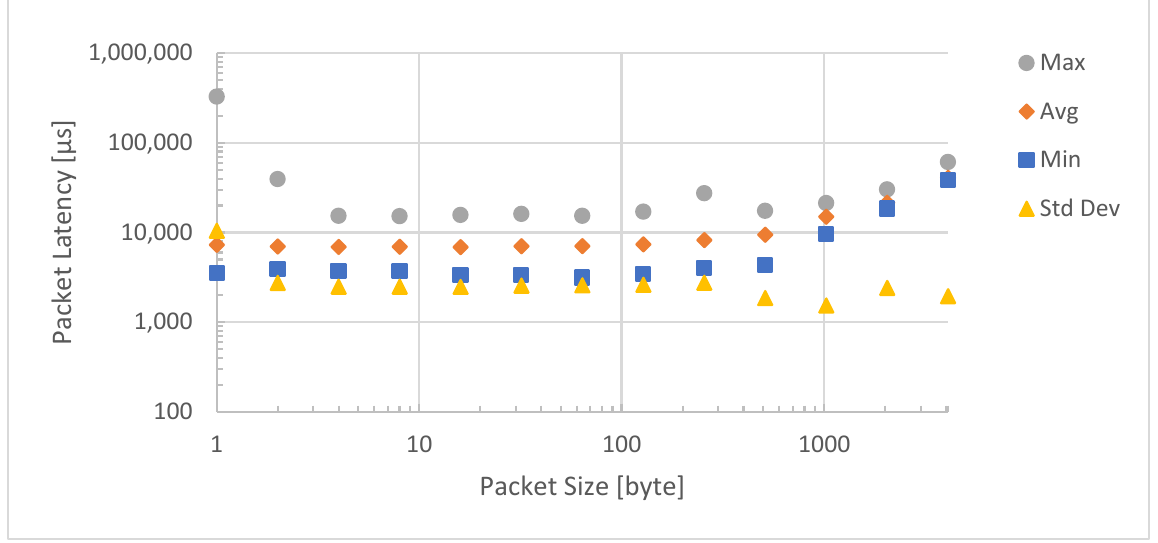
Figure 10. Packet latency for a bridged connection over WIU node to WIU gateway.